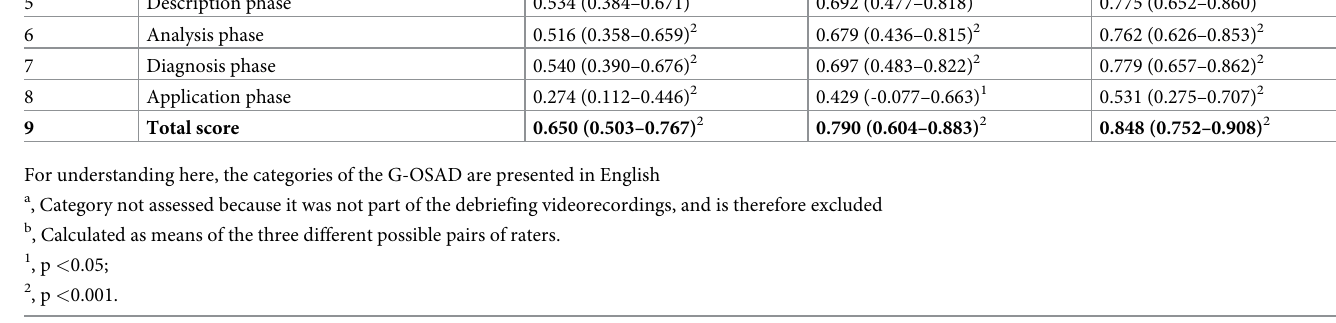
score and ranged between 0.429 to 0.812 for the categories. The single ratings yielded lower ICCs with 0.650 for the total score and a range of 0.274 to 0.678 for the categories (Table 2). excellent [33].